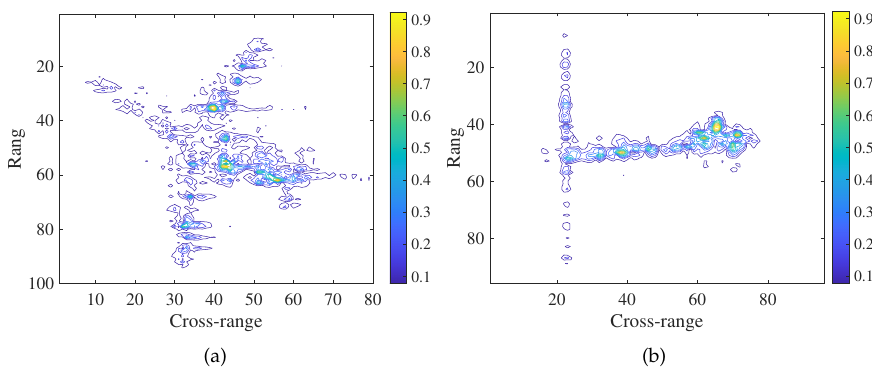
Figure 6. The ( a ) plane image and ( b ) ship image obtained by RD method using full data.